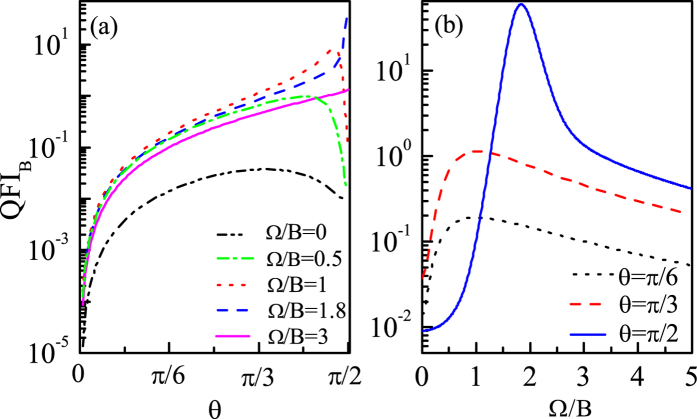
(a) QFIB as a function of θ for different couplings (b) QFIB as a function of Ω for different θ. N = 10, B = 1 and Γ0 = 0.03B.